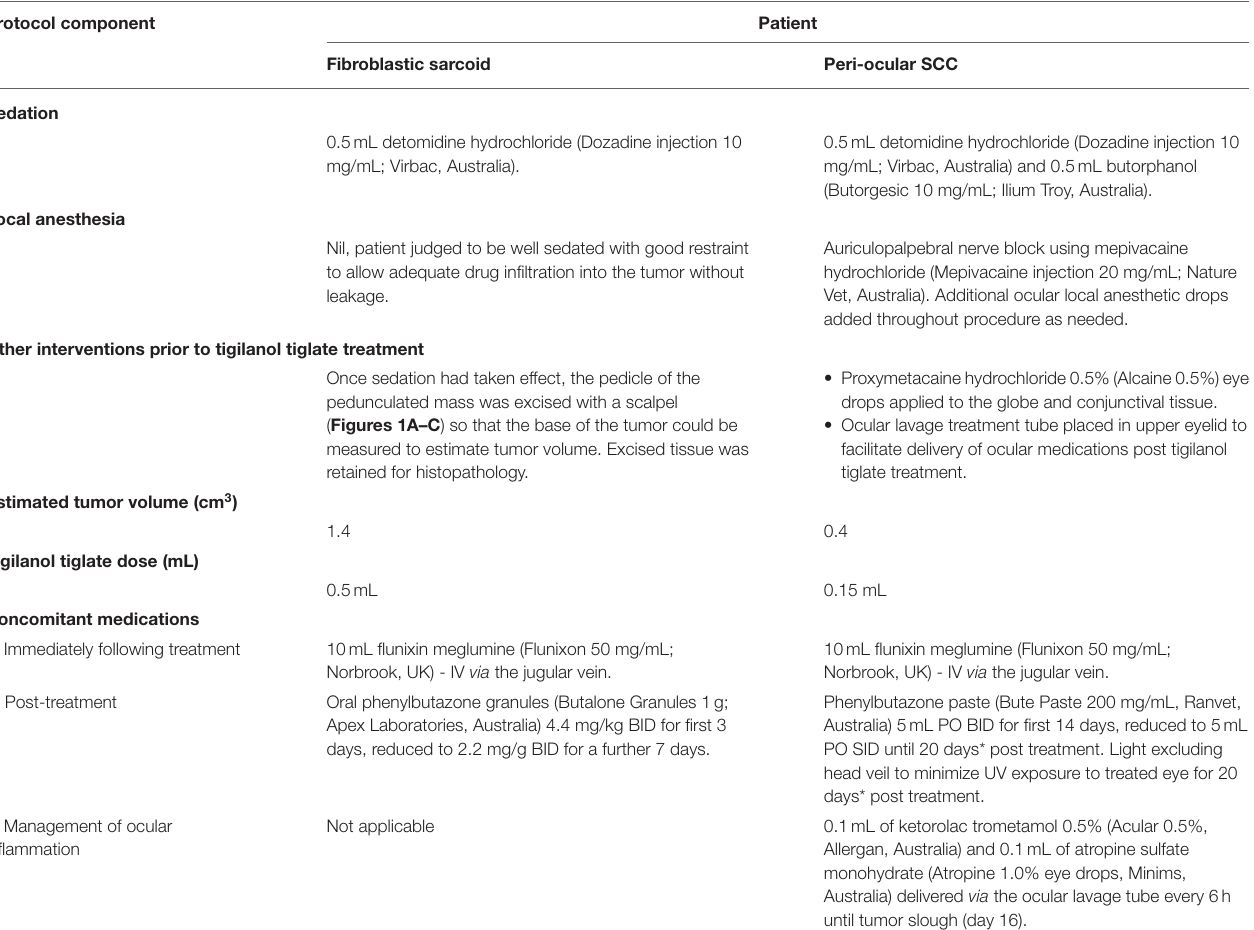
TABLE 2 | Specific details of treatment protocol for the two equine cases treated with intratumoural tigilanol tiglate. Protocol